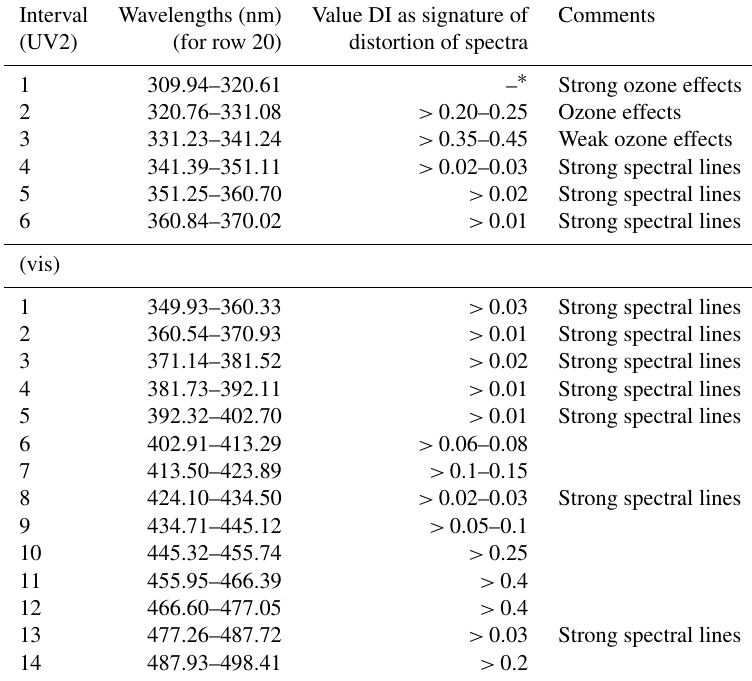
Table 1. Chosen OMI DI spectral intervals and indicative DI thresholds for damaged spectra. Interval Wavelengths (nm) Value DI as signature of Comments (UV2) (for row 20) distortion of